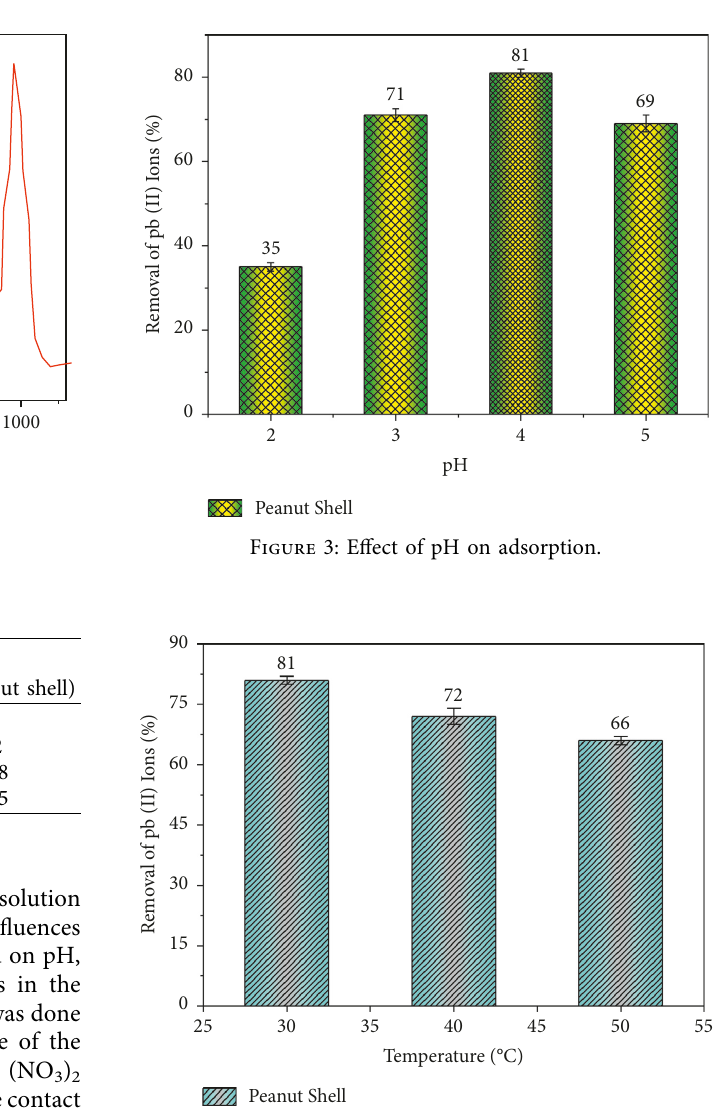
Figure 4: Adsorption rate of Pb ions concerning temperature.